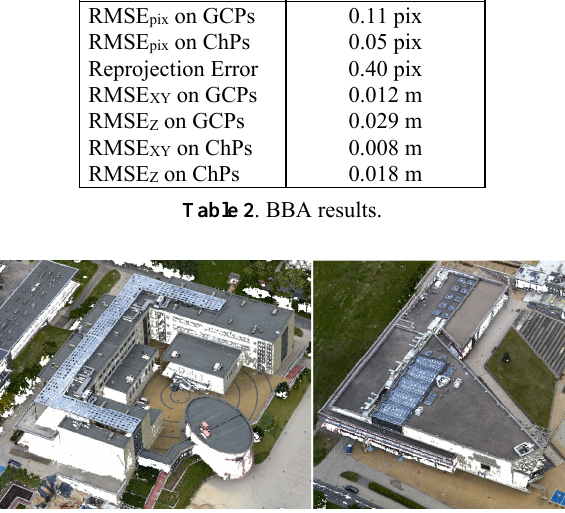
Figure 4 . Image-based point clouds generated in Agisoft Metashape software.